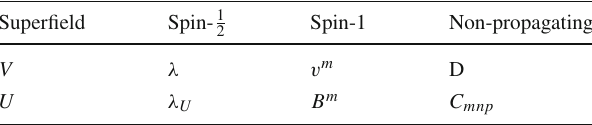
Table 2 The fundamental off-shell component fields of the ordinary real superfield V and of the real three-form multiplet U . The real aux- iliary field D of the multiplet V is here replaced by the real gauge three-form C